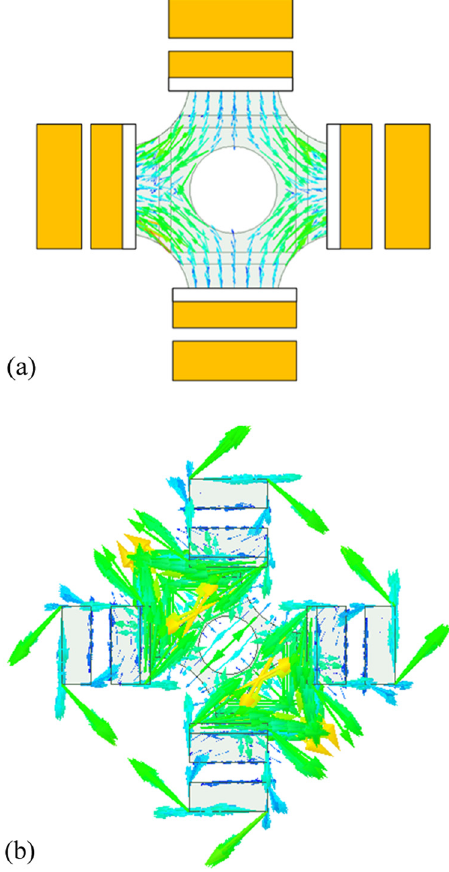
Figure 3: The magnetic fi eld and current of the proposed ECFREL. ( a ) The current of the proposed ECFREL and ( b ) the magnetic fi eld of the proposed